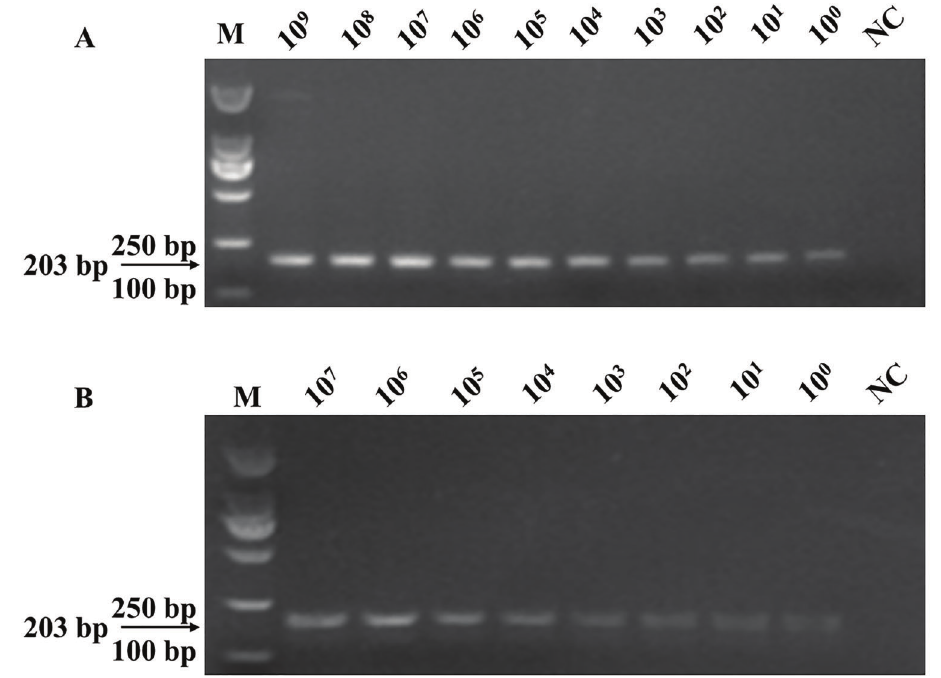
Figure 5. A , Sensitivity of the PCR assay for detecting the target gene of ureR_1 using the primers FIP/BIP. The positive plasmids of K. pneumoniae were serially diluted 10-fold as templates for PCR assay. B , Bacterial solutions were serially diluted 10-fold with the mouse blood with a volume ratio of 1:1. These mixtures were lysed and then the suspension was used for PCR assay. M: 2000 marker; NC: negative control. All experiments were repeated